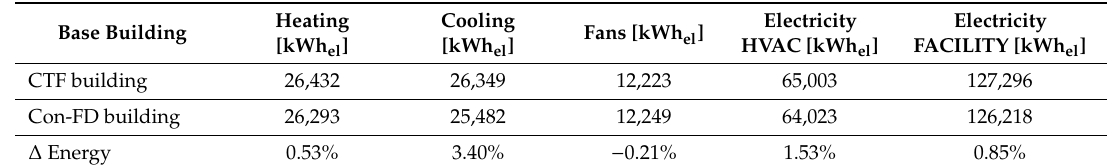
Table 4. Base Building: Di ff erences in electric energy due to the di ff erent simulation algorithm,